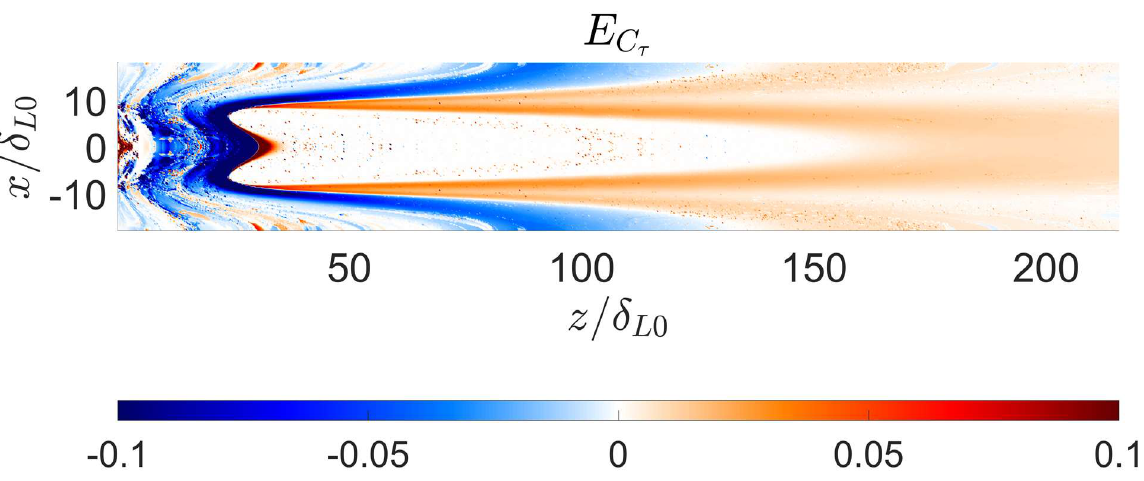
Figure 6. Model error sensitivity to the factor C τ at C τ =